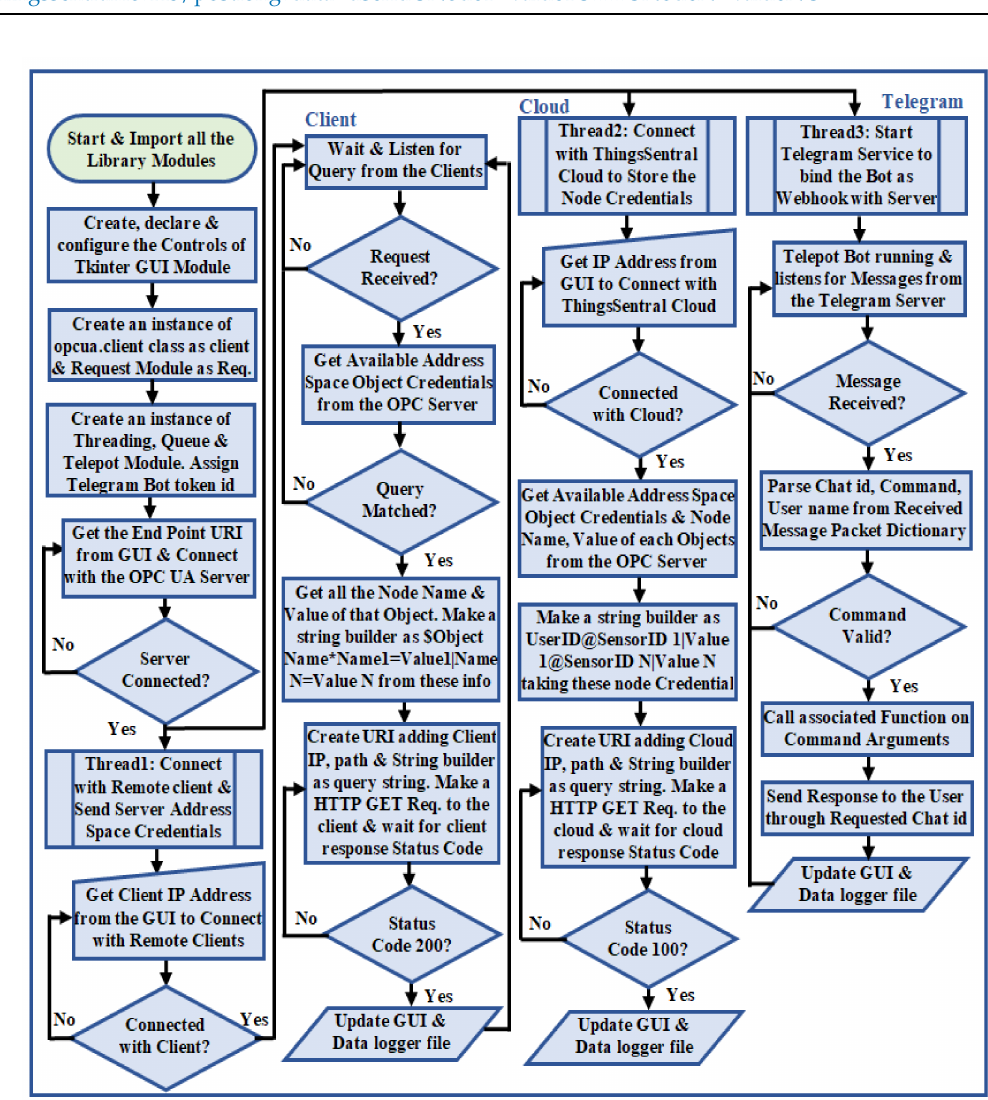
Figure 5. Process flow chart of the developed REST-based OPC UA